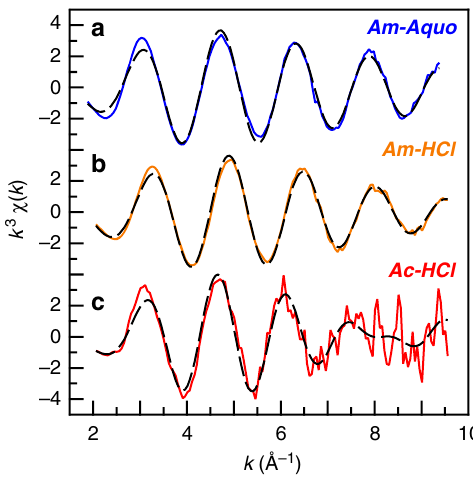
Figure 2 | Solution phase Ac III and Am III L 3 -edge EXAFS. ( a ) EXAFS k 3 w ( k ) spectra for Am-Aquo (0.11M HO 3 SCF 3 ) in blue trace. ( b ) EXAFS k 3 w ( k ) spectra for Am-HCl (11M HCl) in orange trace. ( b ) EXAFS k 3 w ( k ) spectra for Ac-HCl (11M HCl) in red trace. Fits to the data have been provided as dashed black